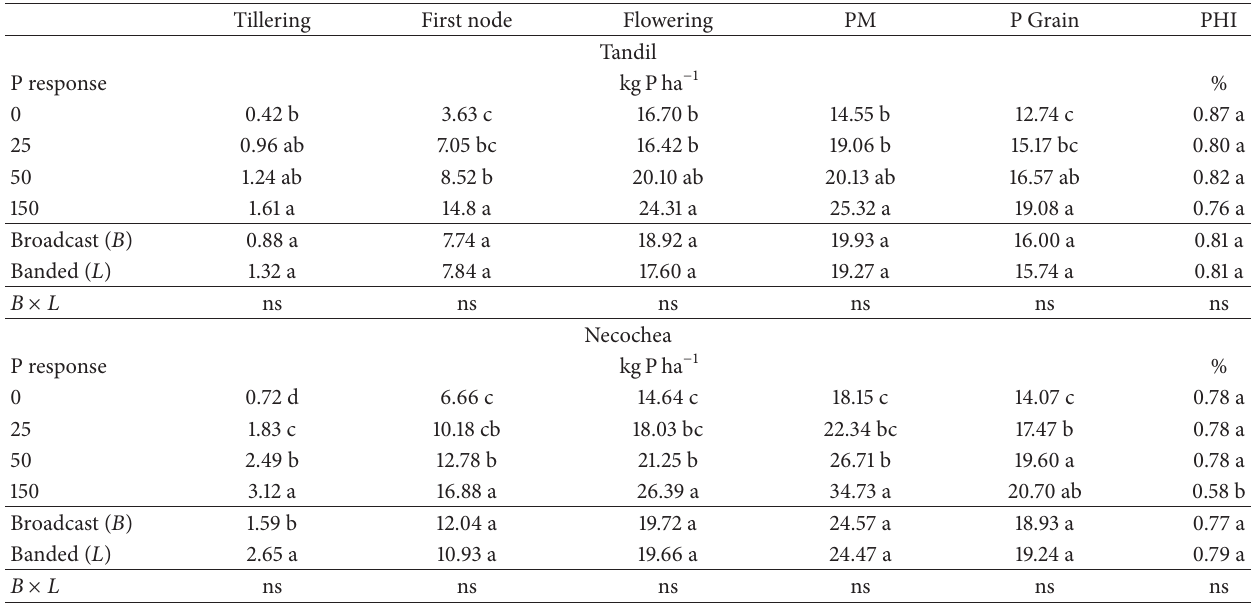
Table 4: Accumulated phosphorous in aerial dry matter. P content in grain and phosphorous harvest index (PHI) at Tandil and Necochea experimental